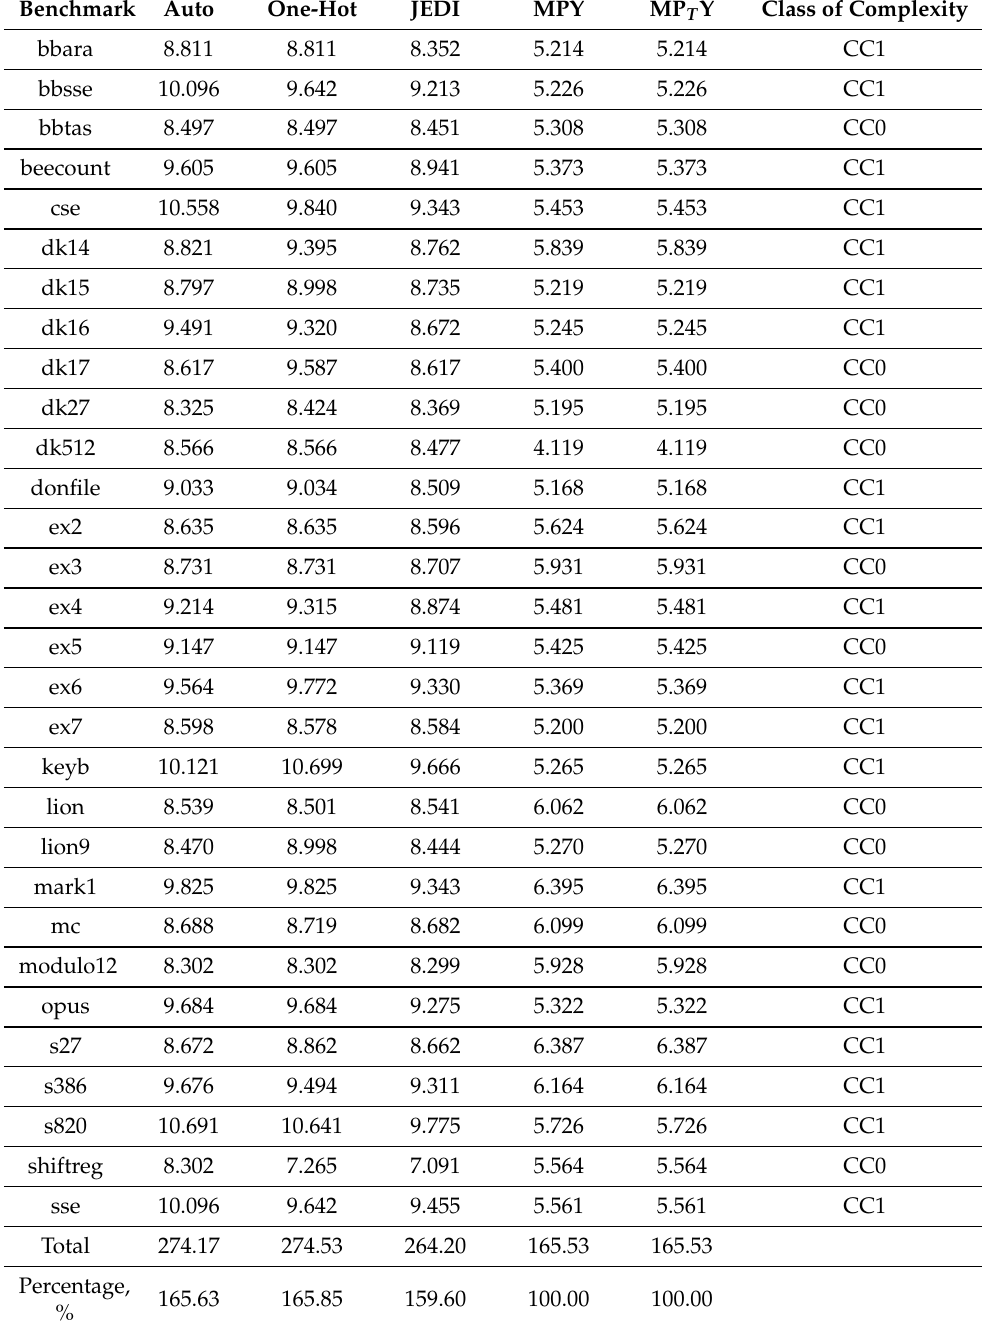
Table 12. Cycle times for classes CC0-CC1